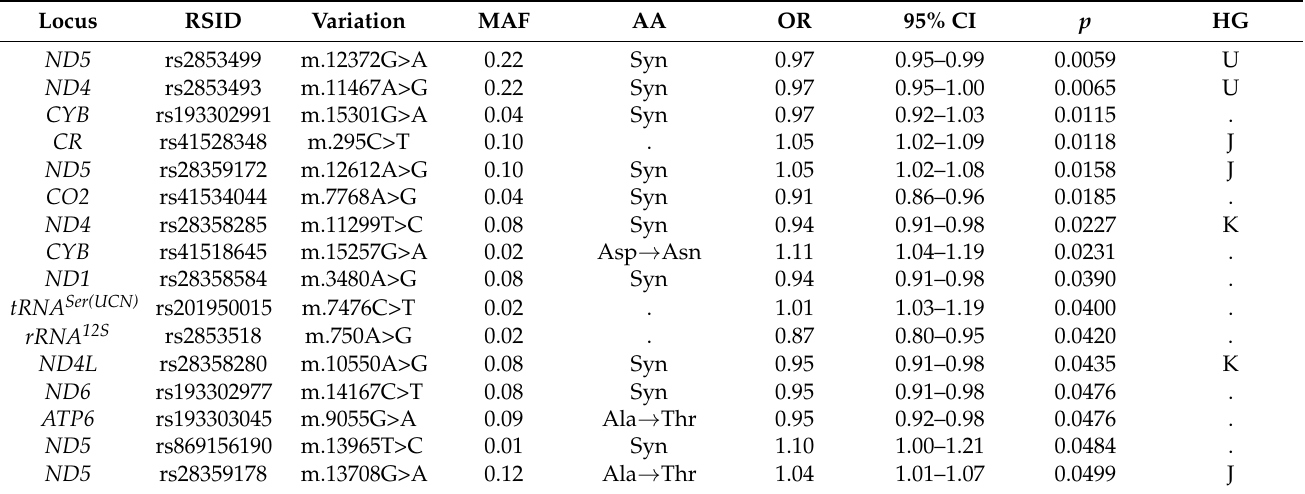
Table 2. HARD CAD common and low-frequency (MAF > 0.01; n = 111) MT-SNV most significant associations. CR = control